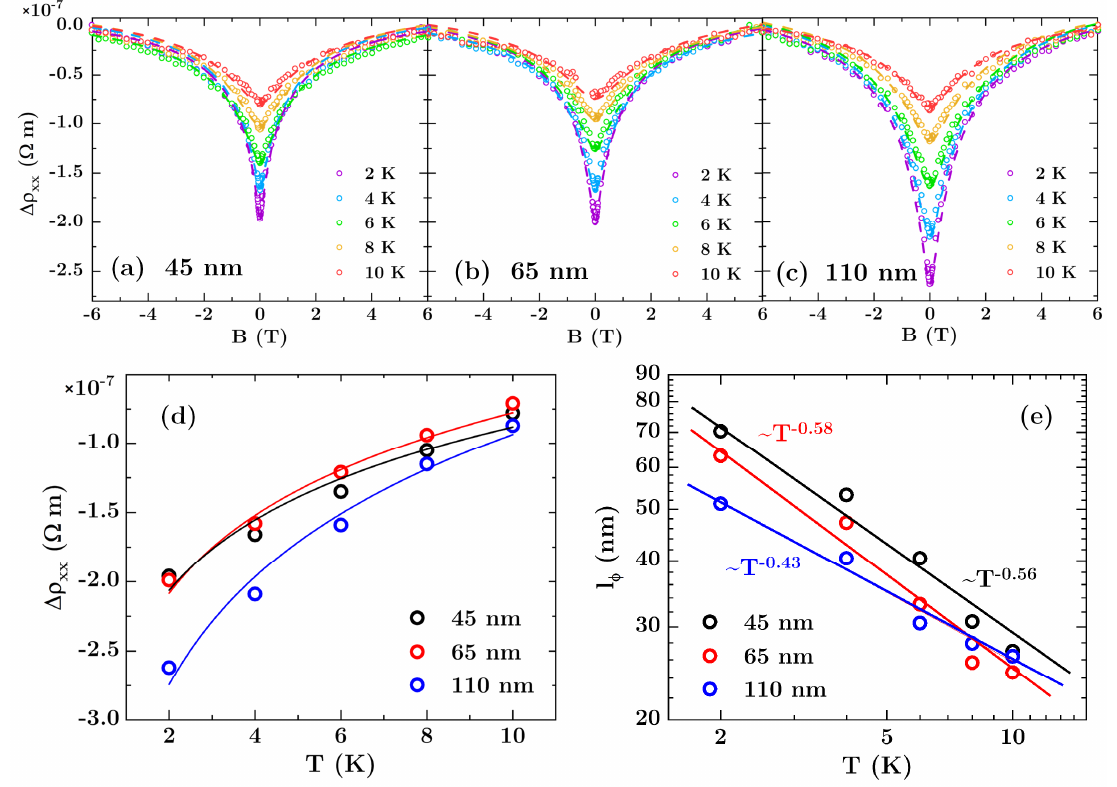
Figure 6. ( a – c ) Longitudinal magnetoresistivity for Bi antidot arrays after subtracting the B-quadratic background. Dashed lines represent theoretical curves fitted to experimental data using Equation (4) and Hikami - Larkin - Nagaoka (HLN) theory. The mean hole diameter is ( a ) 45 nm, ( b ) 65 nm, and ( c ) 110 nm. ( d ) Resistivity deviation from the classical magnetoresistance at low T and B = 0 T due to weak antilocalization. The solid lines represent fit with Equation (3). ( e ) Temperature dependence of phase coherence length l ϕ plotted on a logartithmic scale. The solid lines show the curves obtained by fitting the data to a power-law function of temperature l ϕ ~ T −x .